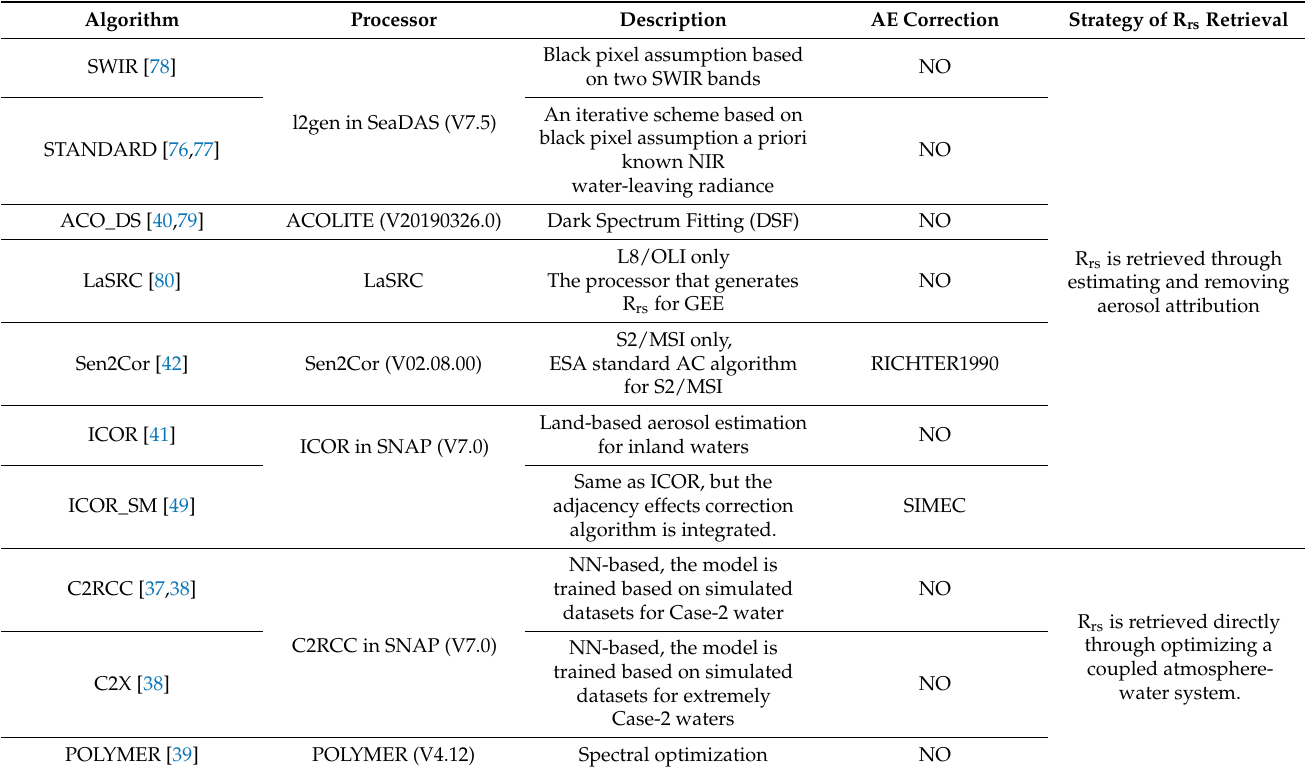
Table 1. List of the AC algorithms used to process L8/OLI and S2/MSI images in this